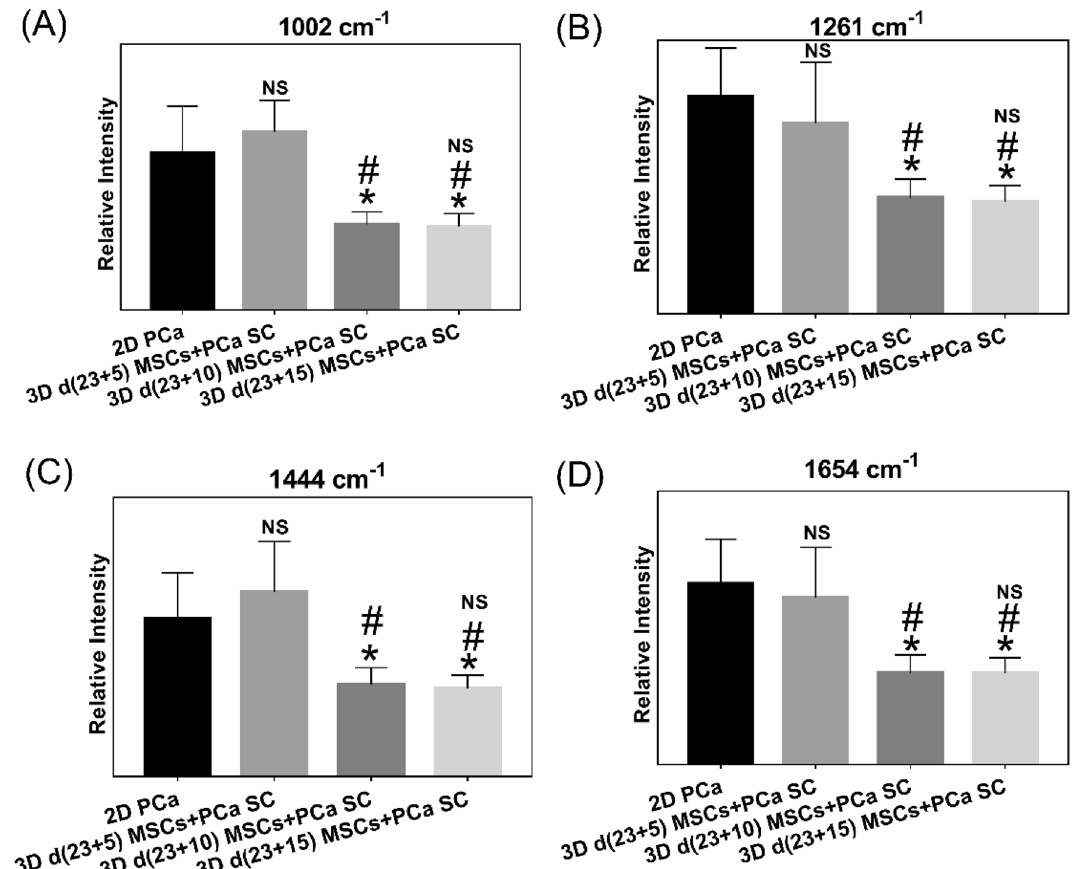
Figure 3. Calculation of Raman band intensity. Twenty cell spectra from each sample were selected for intensity calculation of chosen Raman bands. All spectra were normalized to DNA band at 780 cm −1 before analysis. Histogram displaying intensities of Raman bands ( A ) 1002 cm −1 , ( B ) 1261 cm −1 , ( C ) 1444 cm −1 , and ( D ) 1654 cm −1 across samples. (n = 20, one-way ANOVA followed by post hoc Tukey test, * p < 0.05, ** p < 0.01, and *** p < 0.001 indicate significant difference between 2D PCa and 3D MSCs + PCa SCs; # p < 0.05, ## p < 0.01, and ### p < 0.001 indicate significant difference between day (23 + 5), and other days of 3D MSCs + PCa SCs; $ p < 0.05, $$ p < 0.01, and $$$ p < 0.001 indicate significant difference between day (23 + 10) 3D MSCs + PCa SC and day (23 + 15) 3D MSCs + PCa